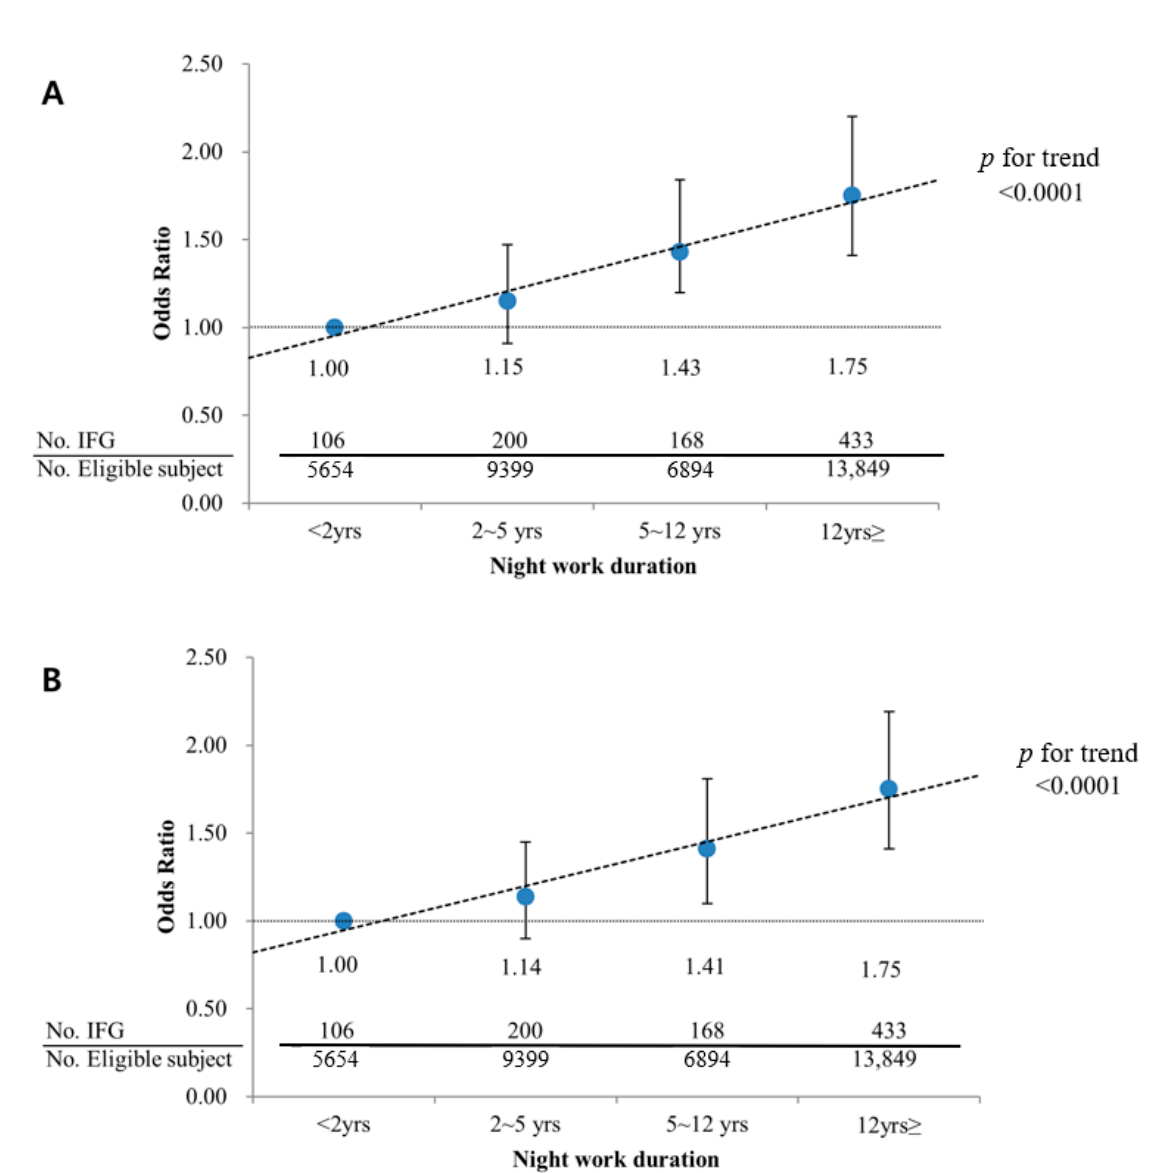
Figure 1. Adjusted odds ratio of IFG (Impaired fasting glucose) according to work duration among subjects over 40 years old. ( A ) Model 1: Adjusted for age, sex, exercise, alcohol habit, smoking, work duration, job type, hypertension, dyslipidemia, obesity (BMI); ( B ) Model 2: Adjusted for age, sex, exercise, alcohol habit, smoking, work duration, job type, hypertension, dyslipidemia, abdominal obesity (waist circumference). Logistic regression analysis was used to estimate the p for trend of odds ratios for IFG with ascending order of duration of night work as continuous variable option.